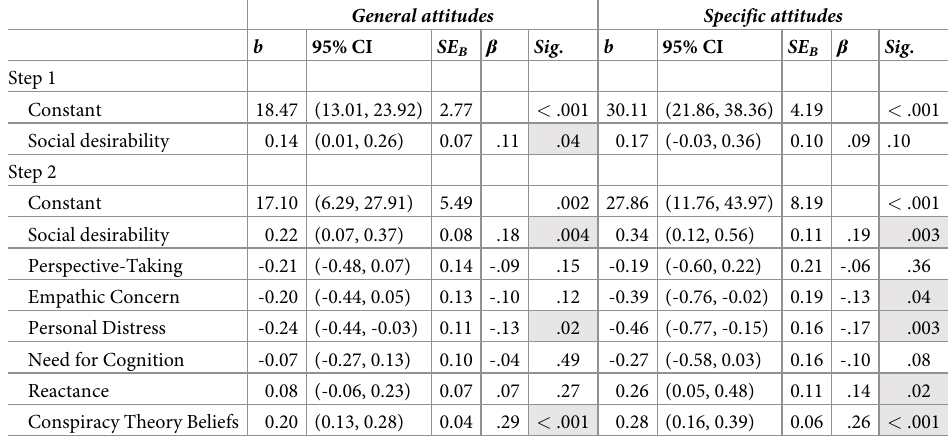
Table 14. Multiple regression for predicting attitudes to easing COVID-19 restrictions for individual differences factors.